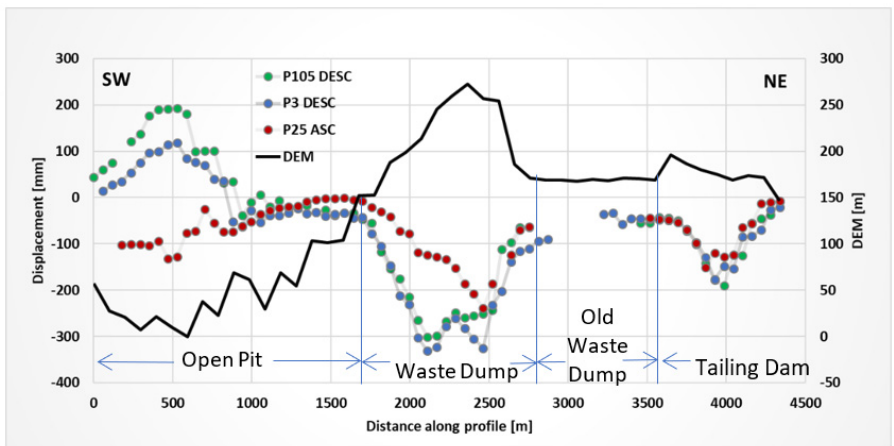
Figure 9. Ground velocity maps for the Anshan pit mine area: ( a ) S1 ascending on path 25; ( b) S1 descending on path 105. Black line represents the profile plotted in Figure 3; ( c ) S1 descending on path 3; ( d ) COSMO-SkyMed (CSK) descending orbit. Note that CSK map has a different colour bar and different spatial scale and layer extent because of the CSK frame.